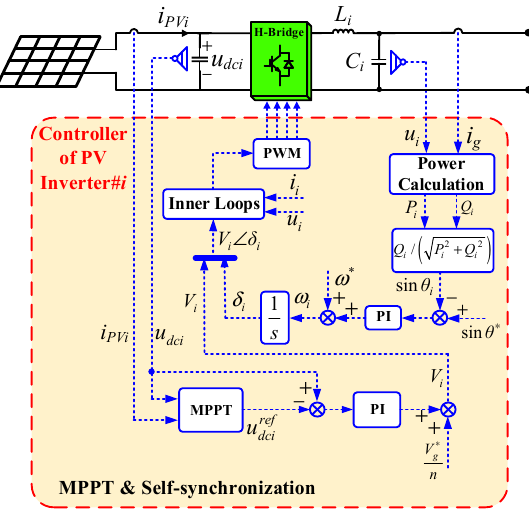
Figure 4. Control diagram of inverter# i ( i = 2, 3, …, n ).